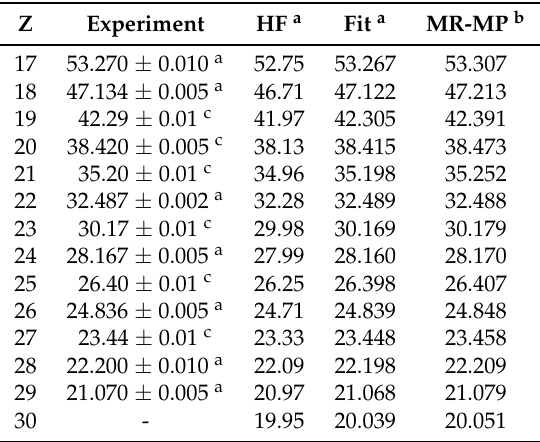
transition wavelengths 9/2